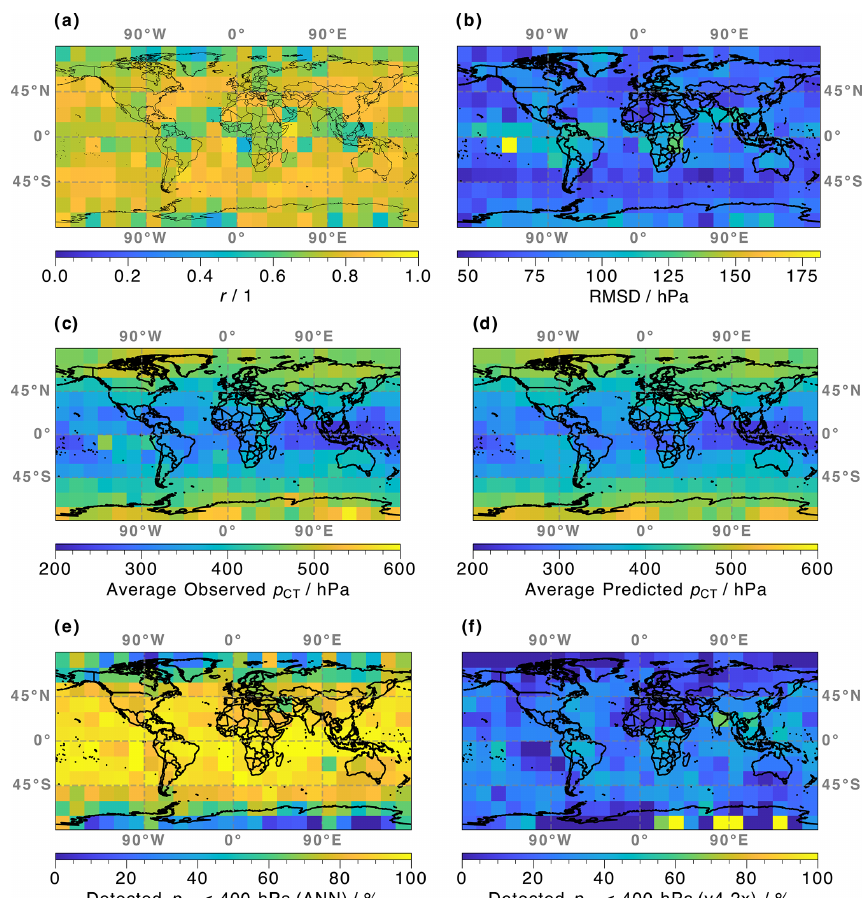
Figure 11. (a) Map of derived Pearson product-moment correlation coefficient ( r ) between MODIS-retrieved and ANN-predicted cloud top pressure ( p CT ). Observations are provided by the colocated MLS–MODIS data set; only profiles from the validation and training data set are considered. (b) Similar to (a) but showing the root mean square deviation (RMSD). (c) Similar to (a) but showing the average MODIS- retrieved p CT . (d) Same as (c) but showing the ANN predictions. (e) Similar to (a) but showing the percent of observed p CT < 400hPa that are successfully detected by the ANN. (f) Same as (e) but showing the percent where the v4.2x algorithm detected a